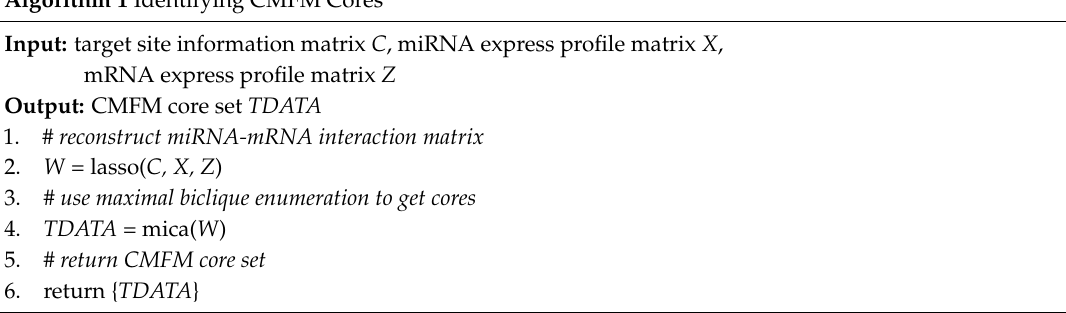
Algorithm 1 Identifying CMFM Cores